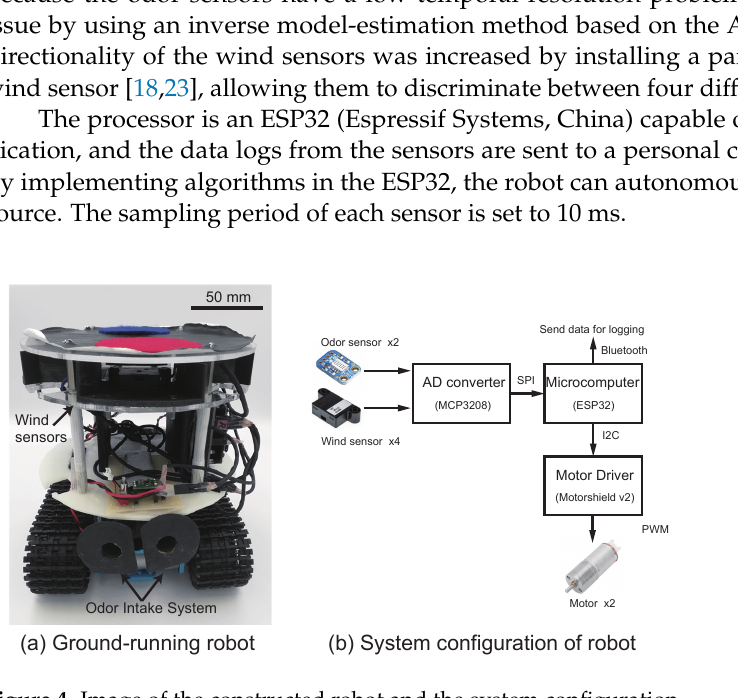
Figure 4. Image of the constructed robot and the system